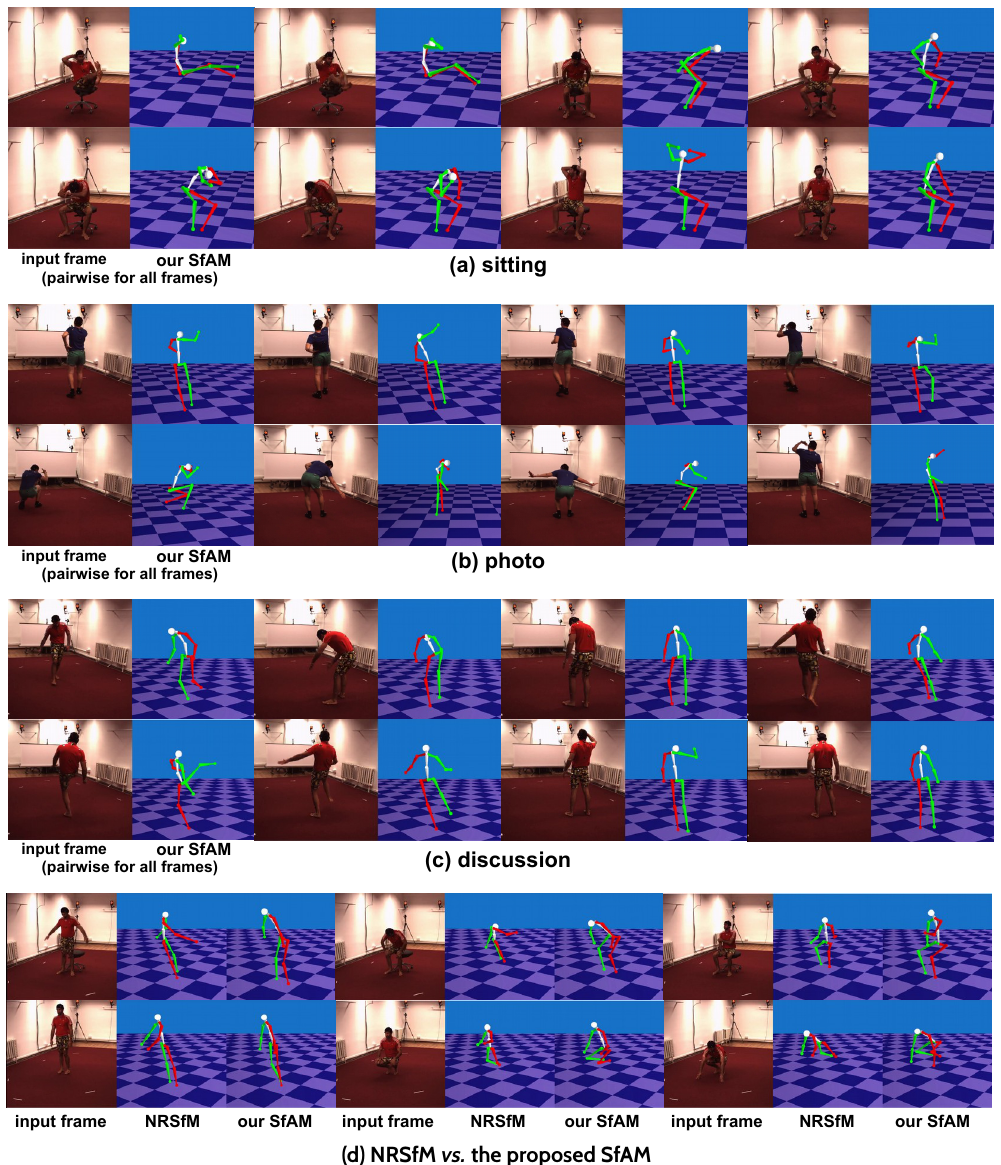
Figure A1. Additional visualizations of our results and reconstructions with NRSfM of Ansari et al. [11] on several sequences from [12]. ( a )–( c ): our results on sitting , photo and discussion . These sequences and poses are among the most challenging in the dataset. ( d ): comparison of our SfAM and NRSfM